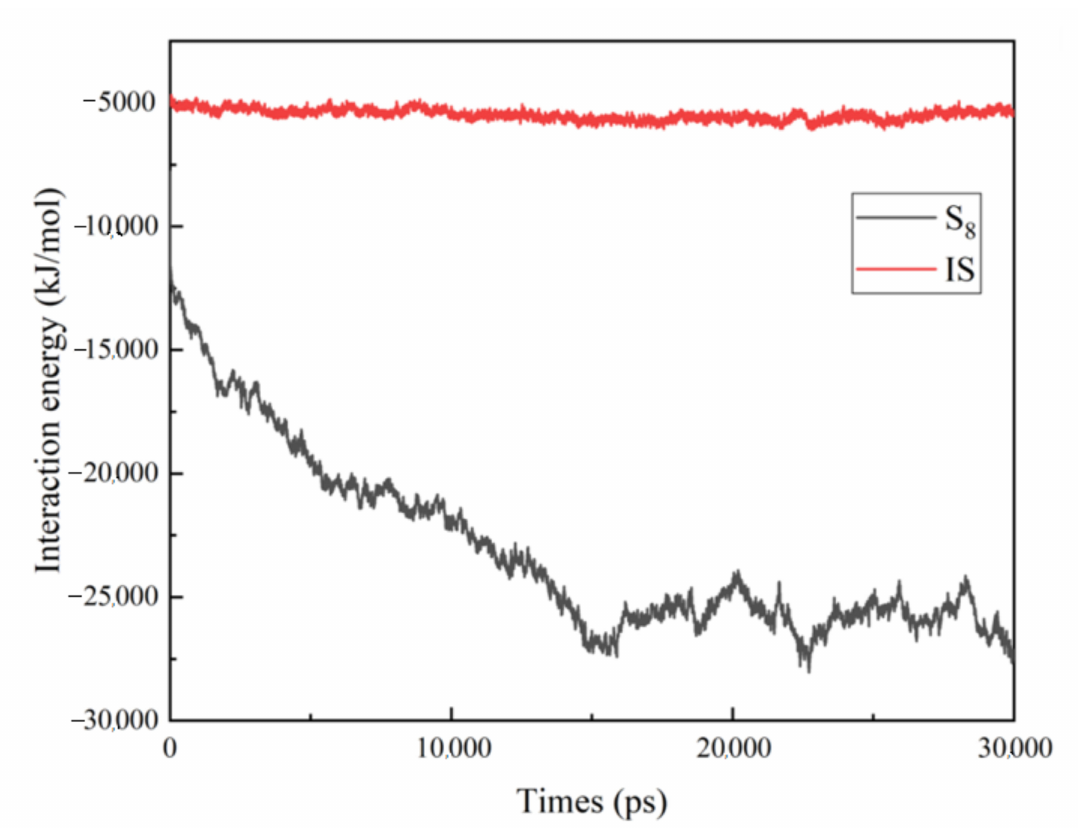
Figure 9. Interaction energies of solute molecules S8 and IS with solvent molecules CS 2 in model A-333 and model B-333 with simulated